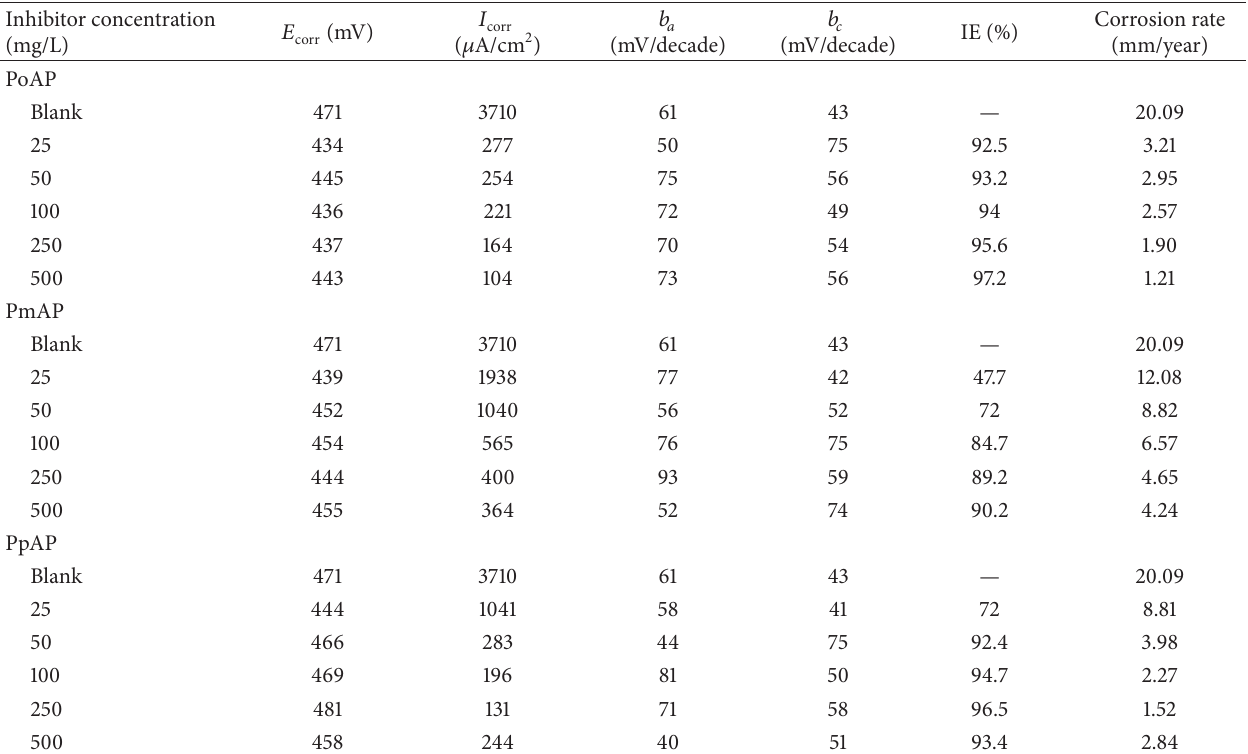
Table 2: Potentiodynamic polarization parameters for mild steel without and with different concentrations of isomers of aminophenol in 1M